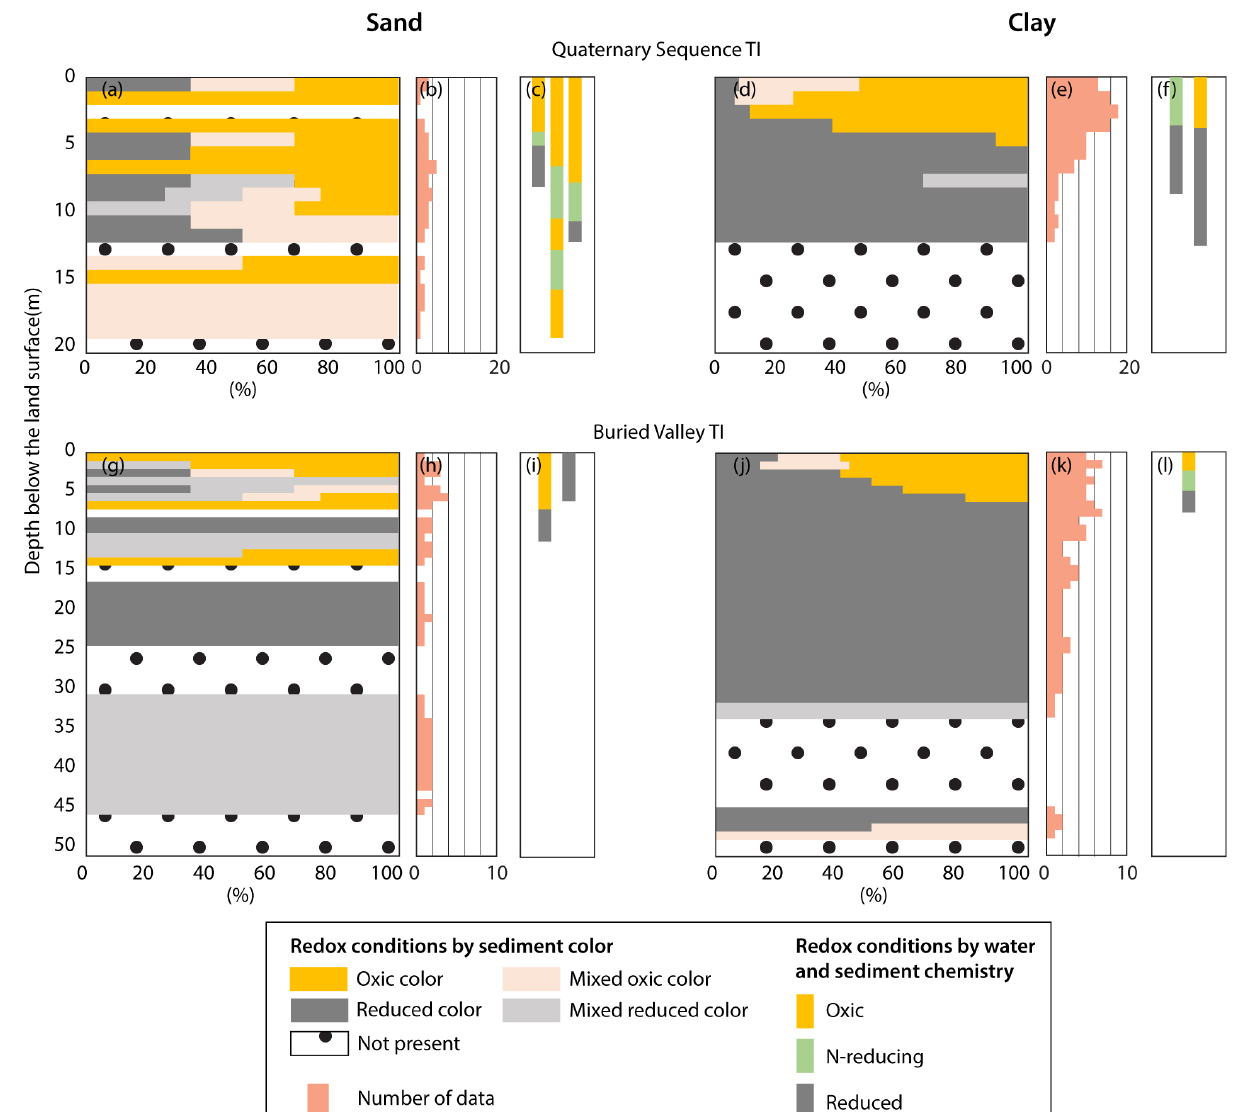
Figure 5. Profiles of redox conditions for sand and clay for each TI area based on geochemical observations. The redox interpretations based on the sediment colors are done separately for sand (a) and clay (d) of the Quaternary sequence TI and of the buried valley TI ( g and j , respectively), and the number of boreholes used in the interpretations are shown in (b) , (e) , (h) , and (k) , respectively. The number of boreholes of each redox color category (oxic, mixed oxic, mixed reduced and reduced colors) are normalized and shown in %. The redox interpretations based on water and sediment chemistry of sand and clay of the Quaternary sequence and buried valley TIs are shown in (c) , (f) , (i) , and (l) ,